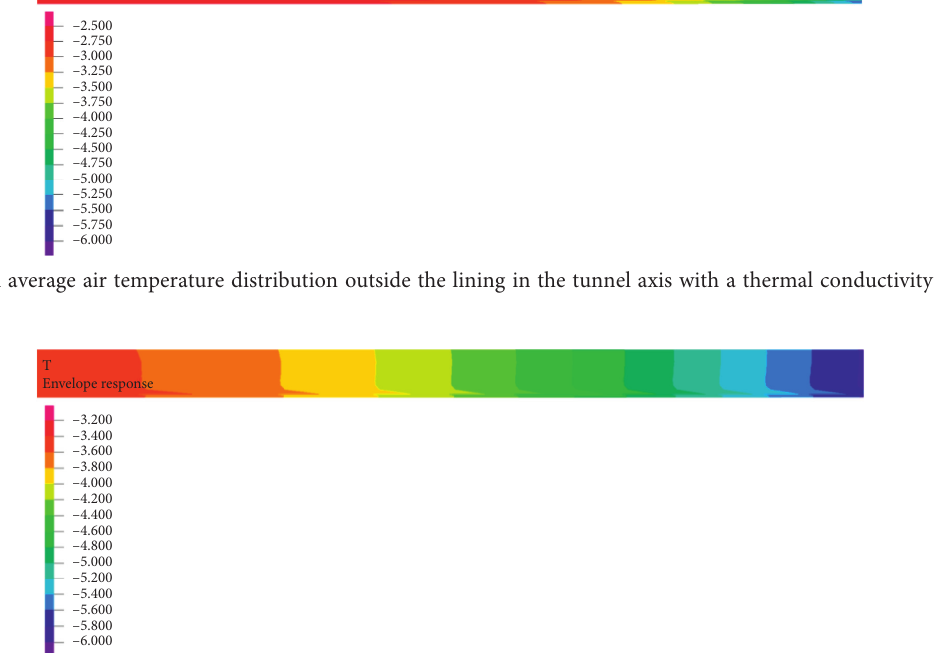
Figure 21: Annual average air temperature distribution outside the lining in the tunnel axis with a thermal conductivity of 0.01 W/(m · °